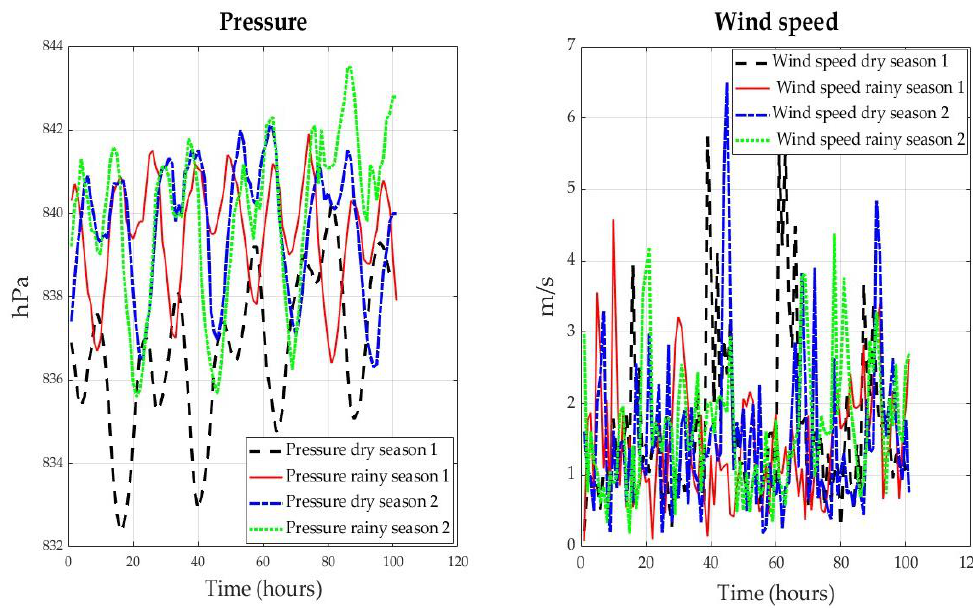
Figure 8. Pressure and wind speed dynamics in different seasons.